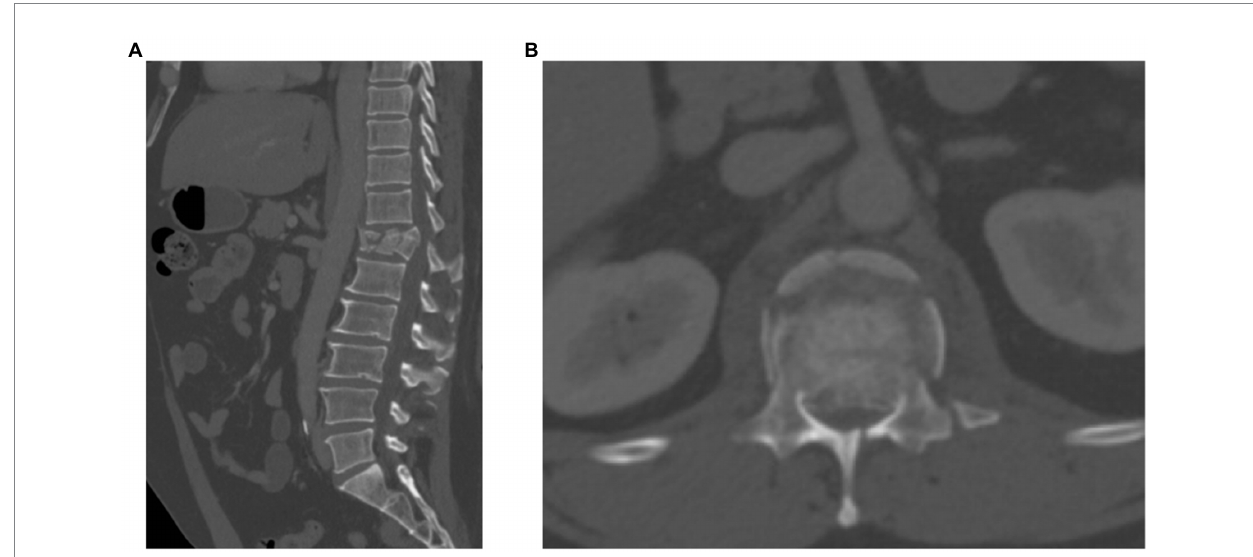
FIGURE 1 CT scan images of thoracolumbar spine demonstrating spinal fracture. (A) Sagittal CT scan showing T12 fracture with comminuted vertebral body. (B) Axial CT scan at T12 level demonstrating violation of the posterior cortex of vertebral body with retropulsion of bone